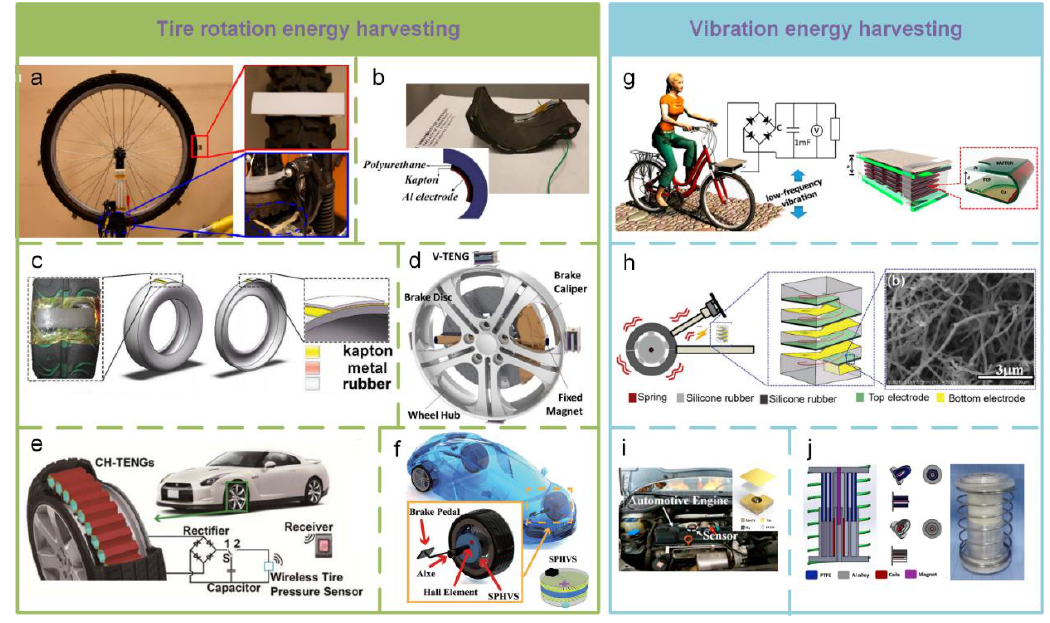
Figure 18. TENGs for tire rotation energy and vehicle’s vibration energy